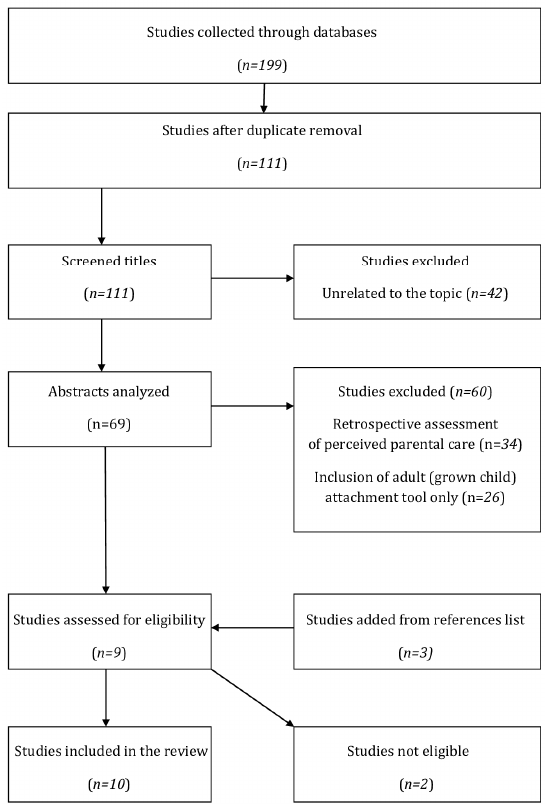
Figure 1. PRISMA (Preferred Reporting Items for Systematic Reviews and Meta-Analyses) flow chart of studies selection.